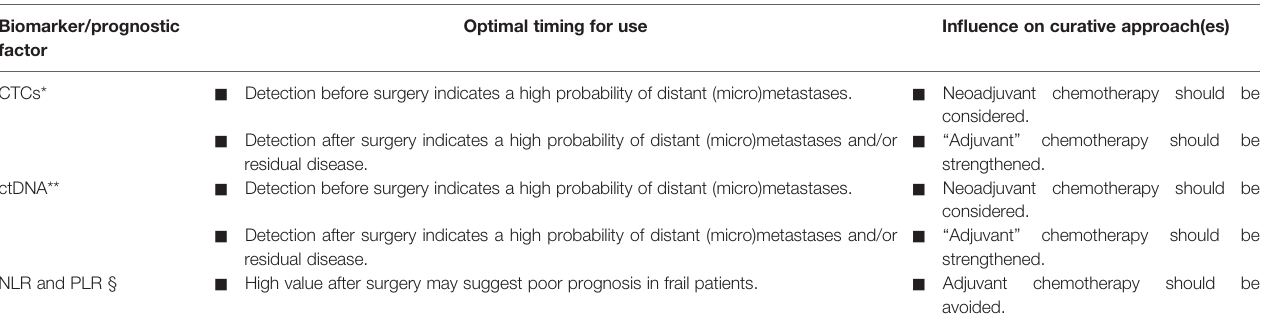
Optimal timing for